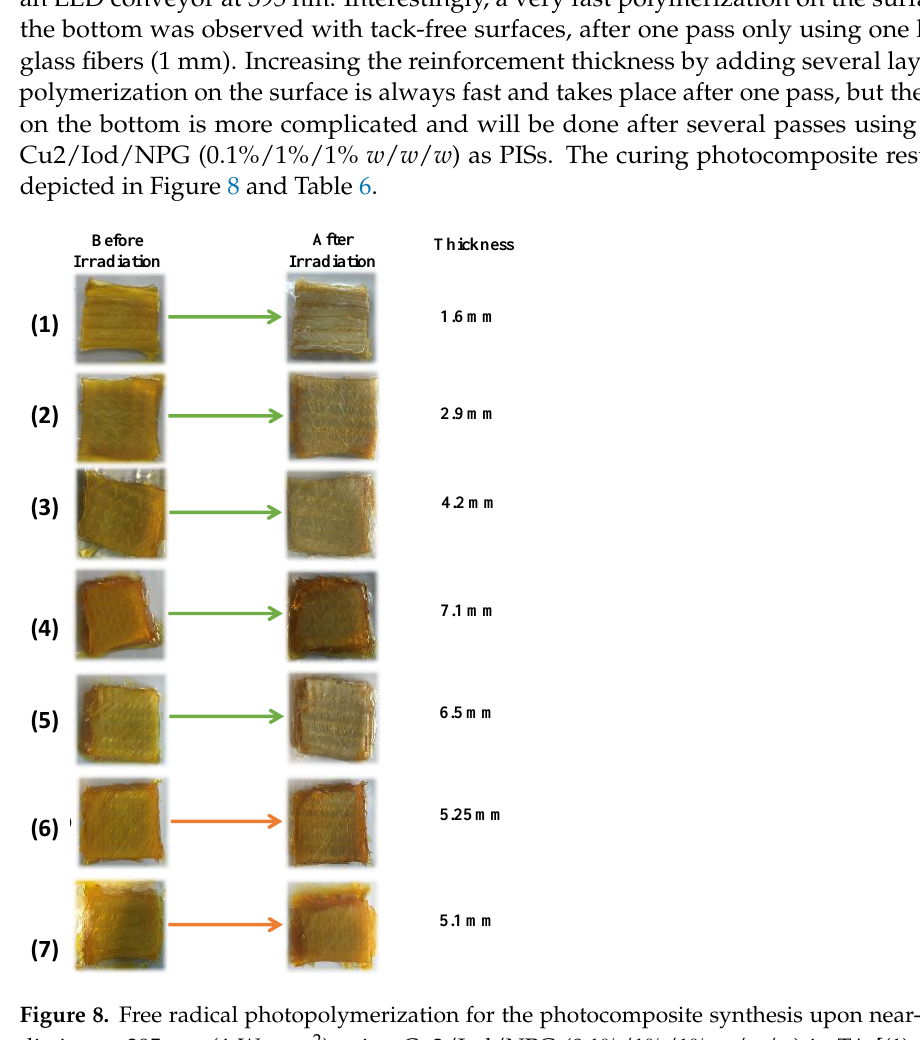
Figure 8. Free radical photopolymerization for the photocomposite synthesis upon near-UV irradiation at 395 nm (4 W · cm − 2 ) using Cu2/Iod/NPG (0.1%/1%/1% w / w / w ) in TA [(1)–(4)], (5)) Cu2/Iod/NPG (0.1%/1%/1% w / w / w ) in TMPTA, (6) Cu1/Iod/NPG (0.1%/1%/1% w / w / w ) in TMPTA and (7) Cu1/Iod/NPG (0.1%/1%/1% w / w / w ) in TA.